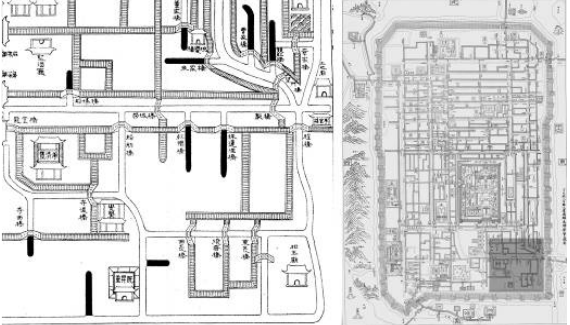
Figure 9 ． Another part from the Map of Pingjiang in the south showing canals being initially for an irrigation purpose.